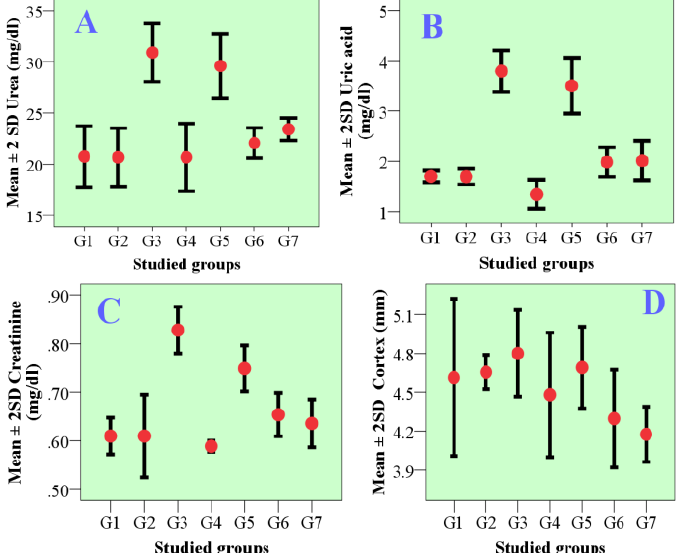
Fig. 3. The comparison of Urea (A), Uric acid (B), Creatinine (C), and Cortex (D) between different studied